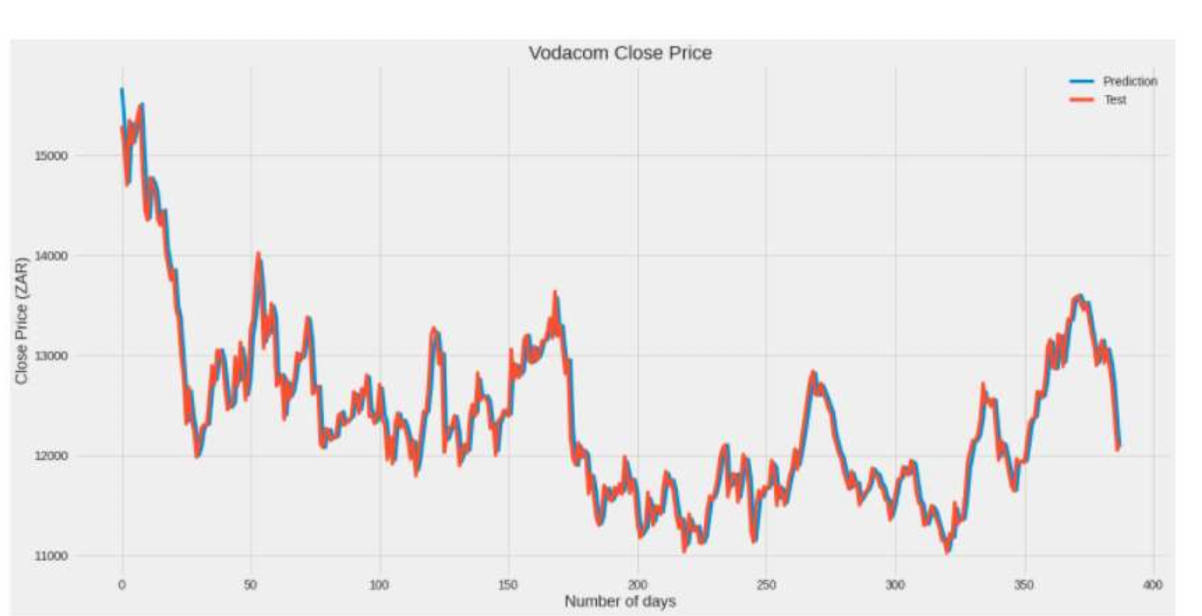
Figure 1. Ordinary LSTM Experiment